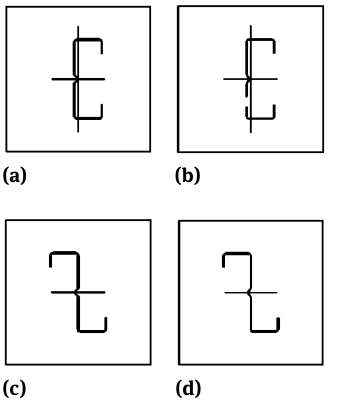
Table 4: Results of calculations, hat profiles with longitude